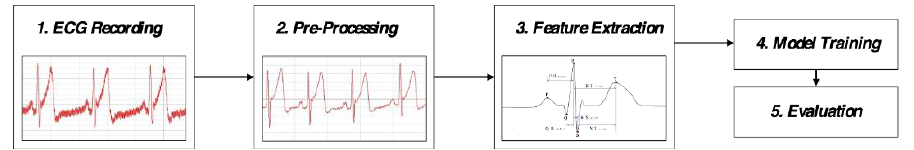
Figure 3. Scheme to implement and evaluate the proposed ECG-based